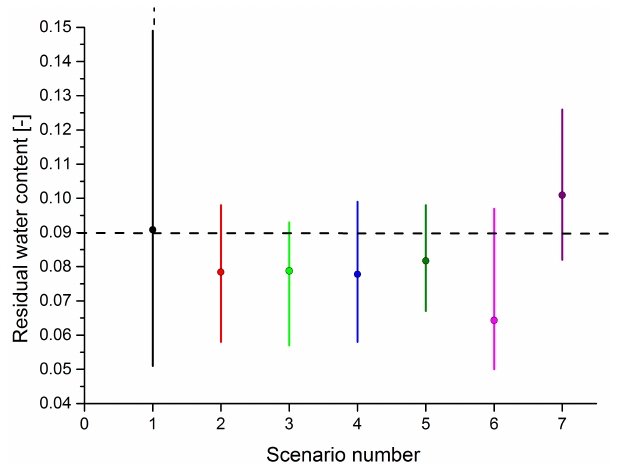
Figure 13. Posterior mean values and 95% confidence intervals of the shape parameter n for the different scenarios.